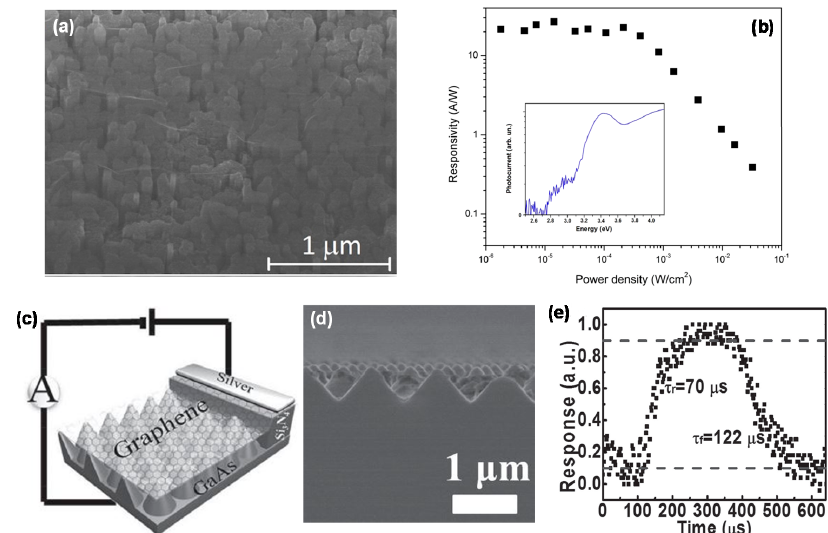
Figure 4. ( a ) Scanning electron microscopy (SEM) image of a graphene film on GaN NWs; ( b ) Responsivity for various incident power densities. The inset shows the photocurrent spectrum of the PD. Reproduced with permission for Figure 4a,b from 2013 Applied Physics Letters [43]; ( c ) Schematic illustration of the graphene/GaAs nanocone array device; ( d ) A typical cross-sectional SEM image of the n -GaAs nanocones array after etching; ( e ) Single normalized cycle at 50 Hz to find both rise time ( τ r ) and fall time ( τ f ). Reproduced with permission for Figure 4c–e from 2014 Advanced Functional Materials [44].